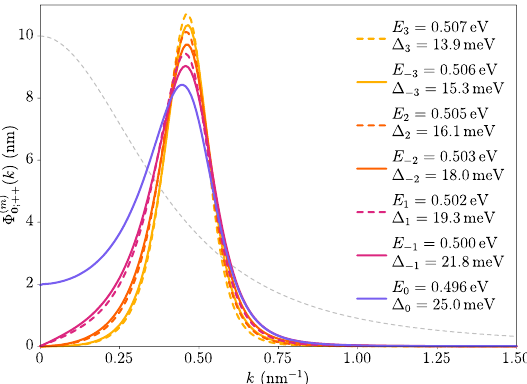
Figure 7. Magnitudes of momentum-space exciton wave functions. These correspond to the zero-momentum , , 0 0 n , m n , m states and and are shown for several values of m as ordered in Fig. 4 and the first | ; + +; � | ; − −; − � available n . The wave functions themselves are obtained by multiplying the magnitude by the corresponding phase e im φ k . The wave functions have a maximum around the momentum at which the energy gap presents a minimum. In particular, the wave function in the s -wave case (purple line) significantly differs from that obtained from the hydrogen problem, which is proportional to (( a 0 k ) 2 10 / √ 8 π nm 1.99 nm , which is suitable for comparison. The values E have set a 0 = ≃ correspond to the excitonic eigenenergies for the same states. The quantities (cid:31) m are the binding energies of each state, that is, the difference between the electron-hole continuum and E m